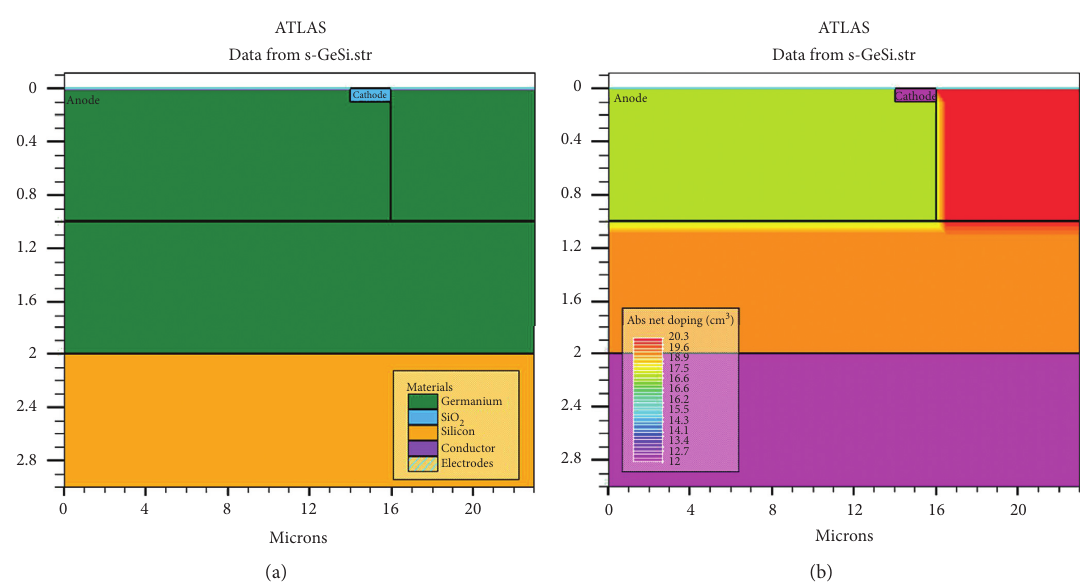
Figure 5: Structure of epitaxial Ge Schottky diode on Si substrate: (a) s-Ge/Si Schottky diode device structure. (b) s-Ge/Si Schottky diode concentration distribution.